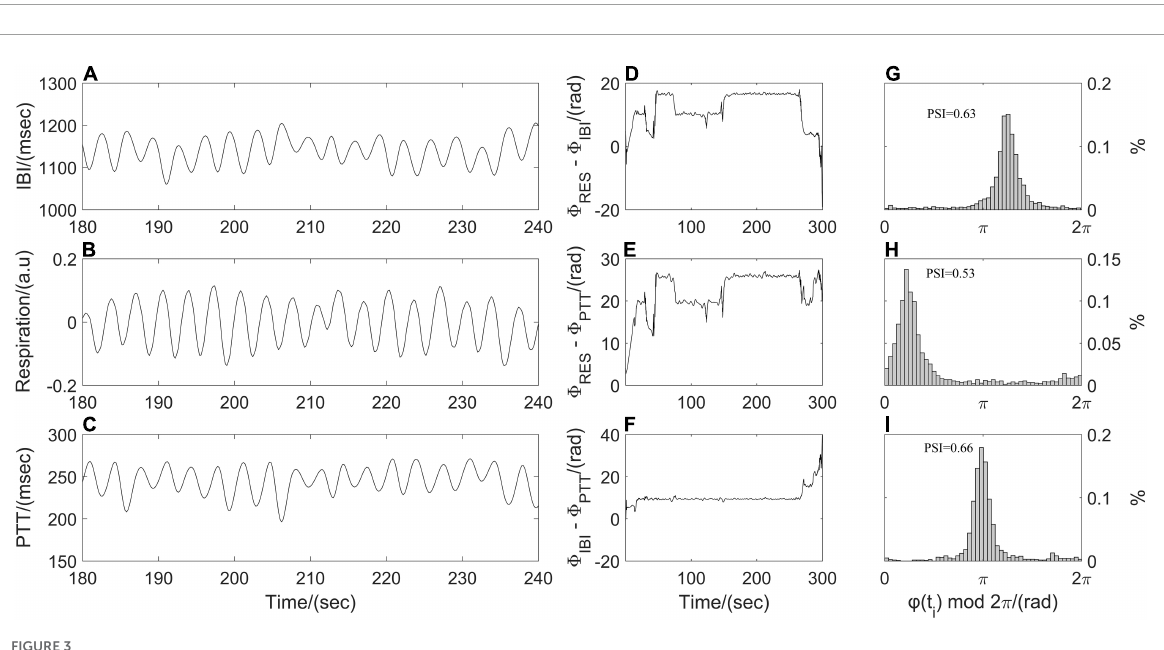
synchronization between two time series, and with a narrower range of phase difference distribution ( Figure 3 ). For two time series in the real world, a constant phase difference, that is,